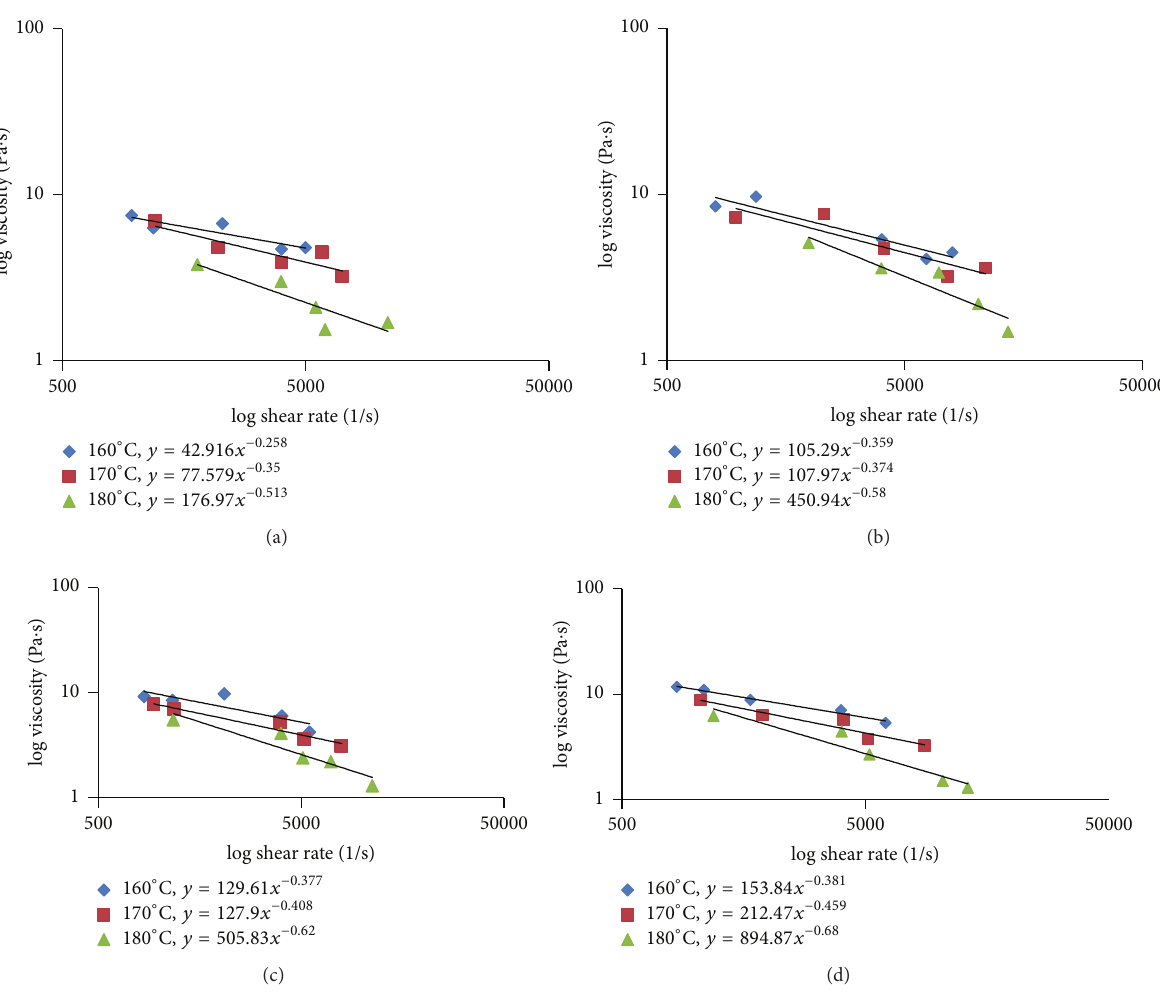
Figure 4: Viscosity results for (a) PGA-63, (b) PGA-66, (c) PGA-69, and (d) PGA-72